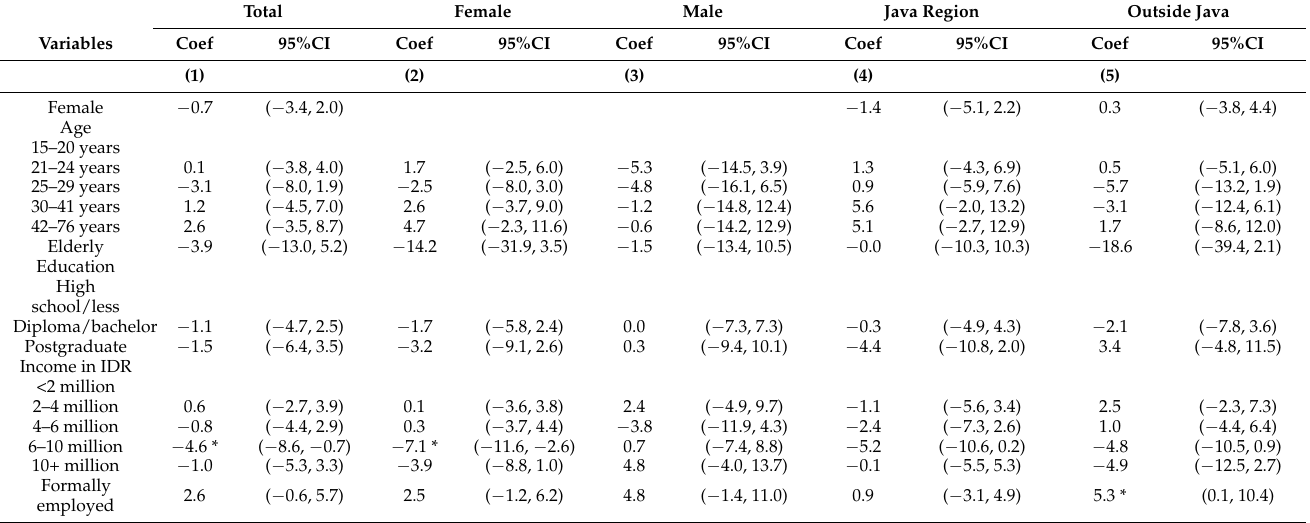
Table 4. Socioeconomic and geographic inequalities in days to receive the COVID-19 vaccine: second